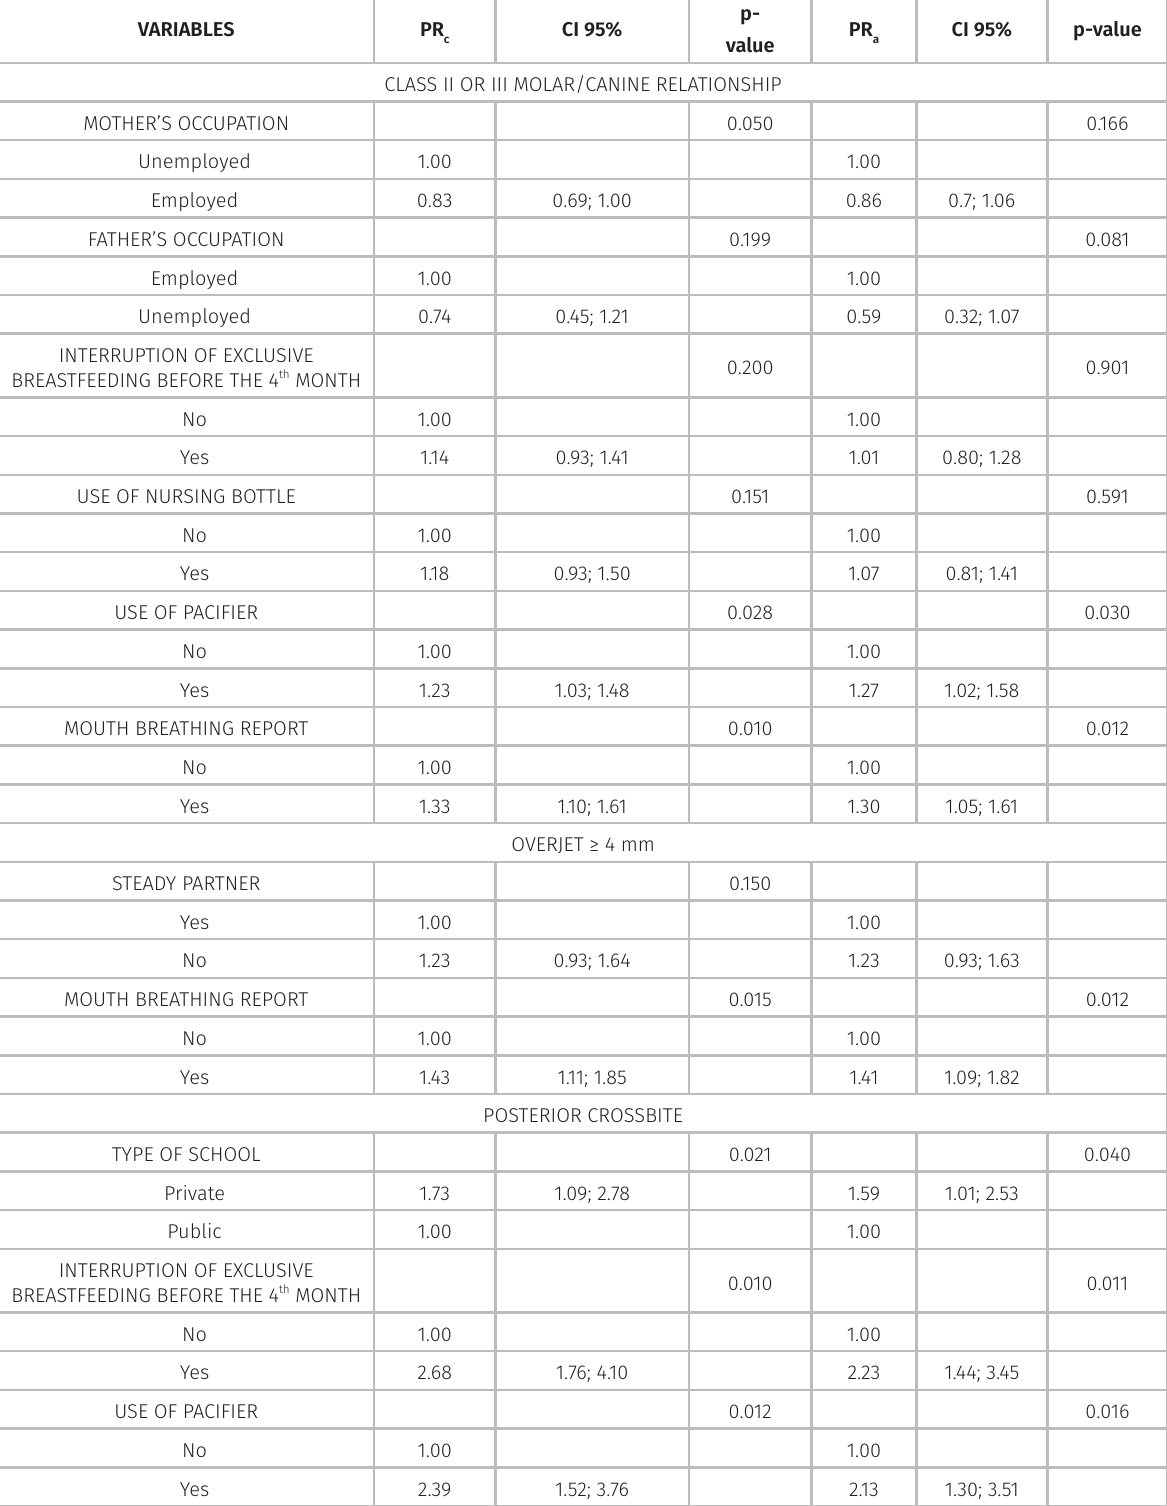
Table V. Results of the multivariate analysis for Class II or III molar/canine relationship, overjet ≥ 4 mm, posterior crossbite and anterior open bite. 6-year-old schoolchildren. Palhoça/SC, Brazil.